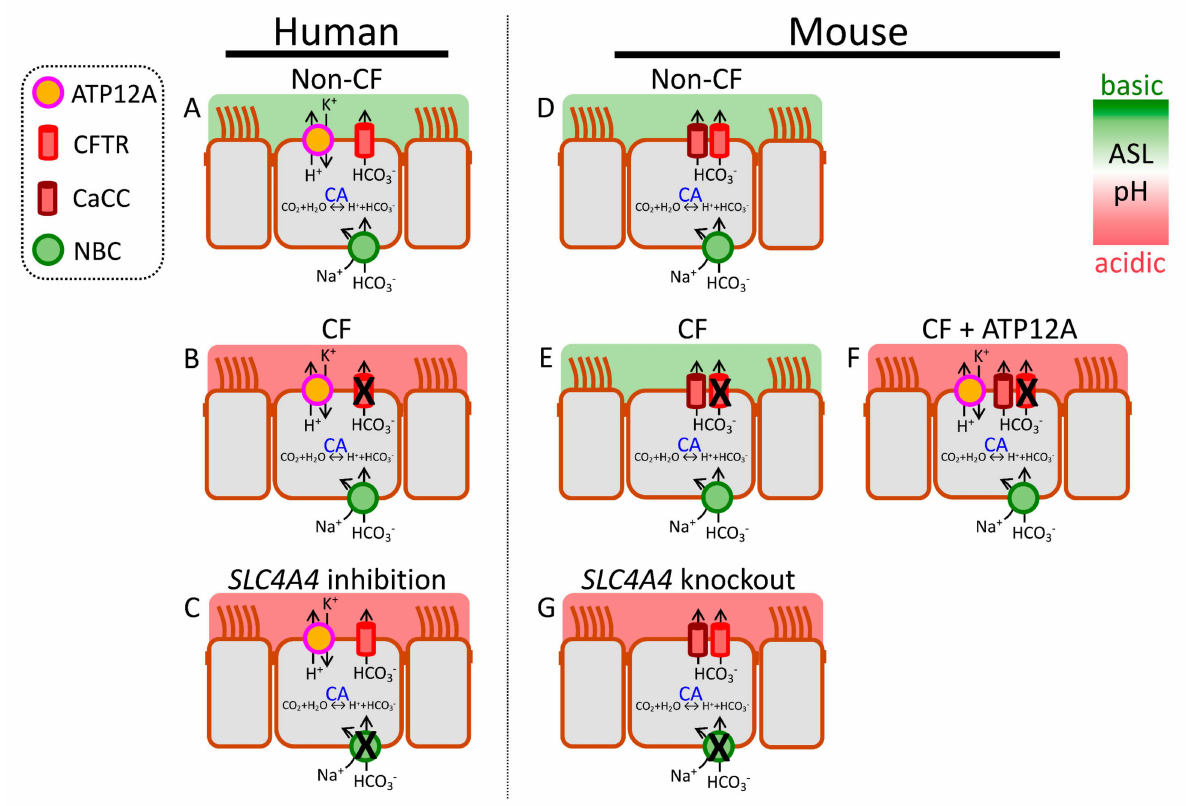
Figure 2. Acid–base transporters that control pH ASL differ between human and mouse airways. Models show key transport mechanisms that determine pH ASL in human and mouse airway epithelia. Left panel (human): ( A ) a model of non-CF airway epithelium with ASL overlying the apical membrane; ( B ) loss of CFTR-mediated HCO 3 − secretion resulting in a lower pH ASL ; ( C ) inhibition of basolateral NBC diminishes HCO 3 − secretion and lowers pH ASL despite intact apical CFTR channels. Right panel (mouse): ( D ) a model of non-CF (wild type) mouse airway epithelium. Note the absence of ATP12A and the expression of non-CFTR (CaCC) HCO 3 − channels; ( E , F ) in contrast to humans, loss of CFTR fails to lower pH ASL in CF mice, providing one explanation for lack of spontaneous airway disease. However, exogenous ATP12A expression increases H + secretion and lowers CF mouse pH ASL ; ( G ) SLC4A4 − / − mice phenocopy human CF. For simplicity, only the chief acid–base transport mechanisms controlling pH ASL are shown. We do not show Na + /H + exchangers, Cl − /HCO 3 − exchangers, Na + and K + channels, or Na + /K + -ATPase, which may also influence the movement of acid–base equivalents into or out of ASL. See legend and text for details. CA = carbonic